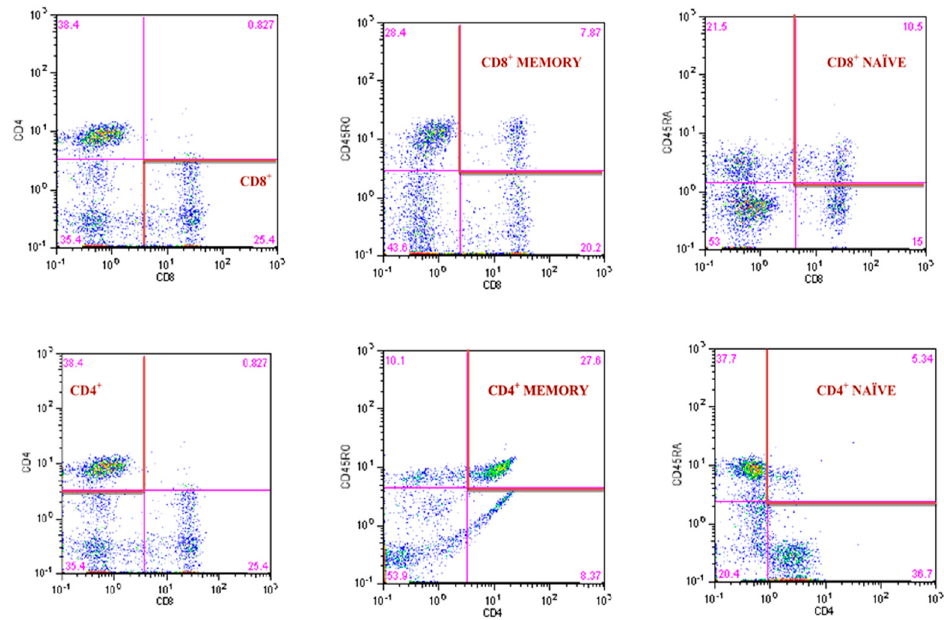
Figure 3. Gating strategy for identifying the CD4 + and CD8 + T lymphocyte and the frequency of CD4 + and CD8 + naïve and memory T